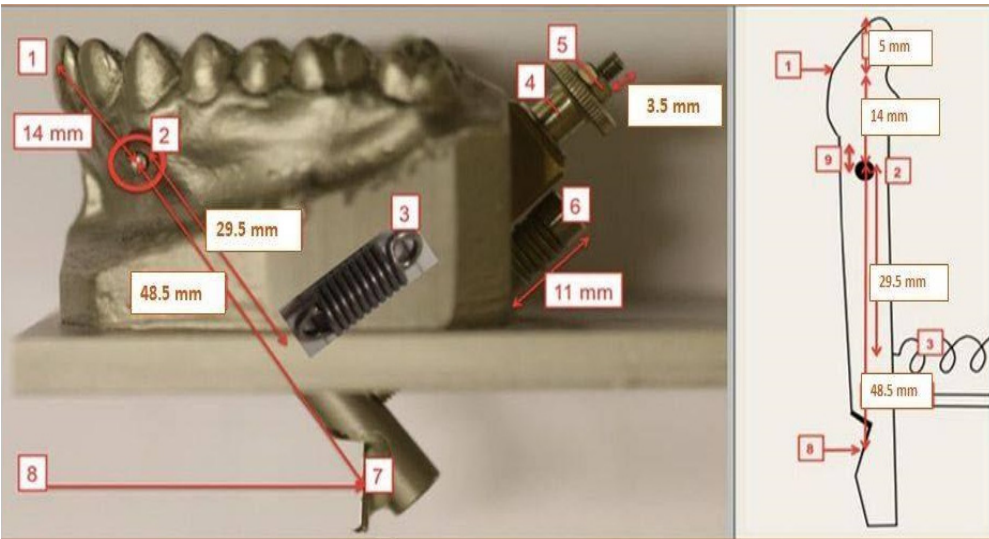
Figure 1. Stainless steel jaw model: ( 1 ) The pendulum strikes 14 mm above the rotation axis on the upper right incisor, ( 2 ) rotation axis, ( 3 ) tension spring (fixed to the extended tooth root inside the jaw model, 29.5 mm below the rotation axis), ( 4 ) screws, nuts and washers (holding the tension spring), ( 5 ) counter nut (fixes and prevents spring preload), ( 6 ) counter screw (prevents tooth movement to vestibular direction), ( 7 ) reflection foil, ( 8 ) laser beam hits 48.5 mm pointed to the reflection foil, ( 9 ) limbus alveolaris level 6.27 mm above the rotation axis and 2.73 mm below the gingival margin. Courtesy of Bochnig et al. [8].